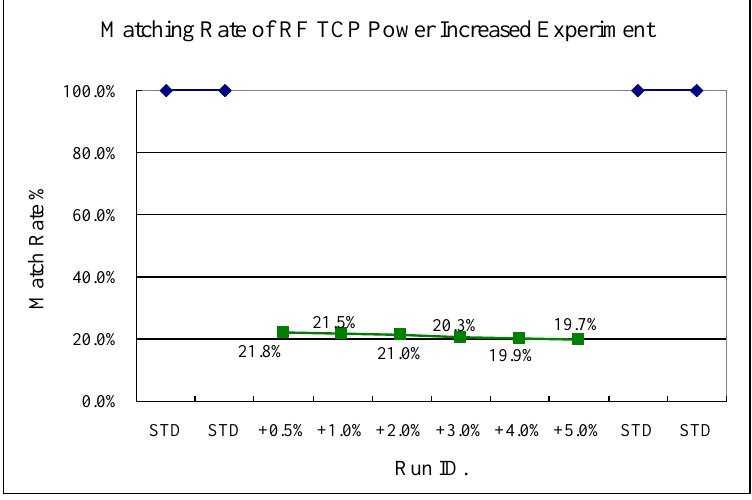
Figure 15. Experiment 6, TCP RF power variance tested from 502.5 to 525 W. (STD = 500 W).